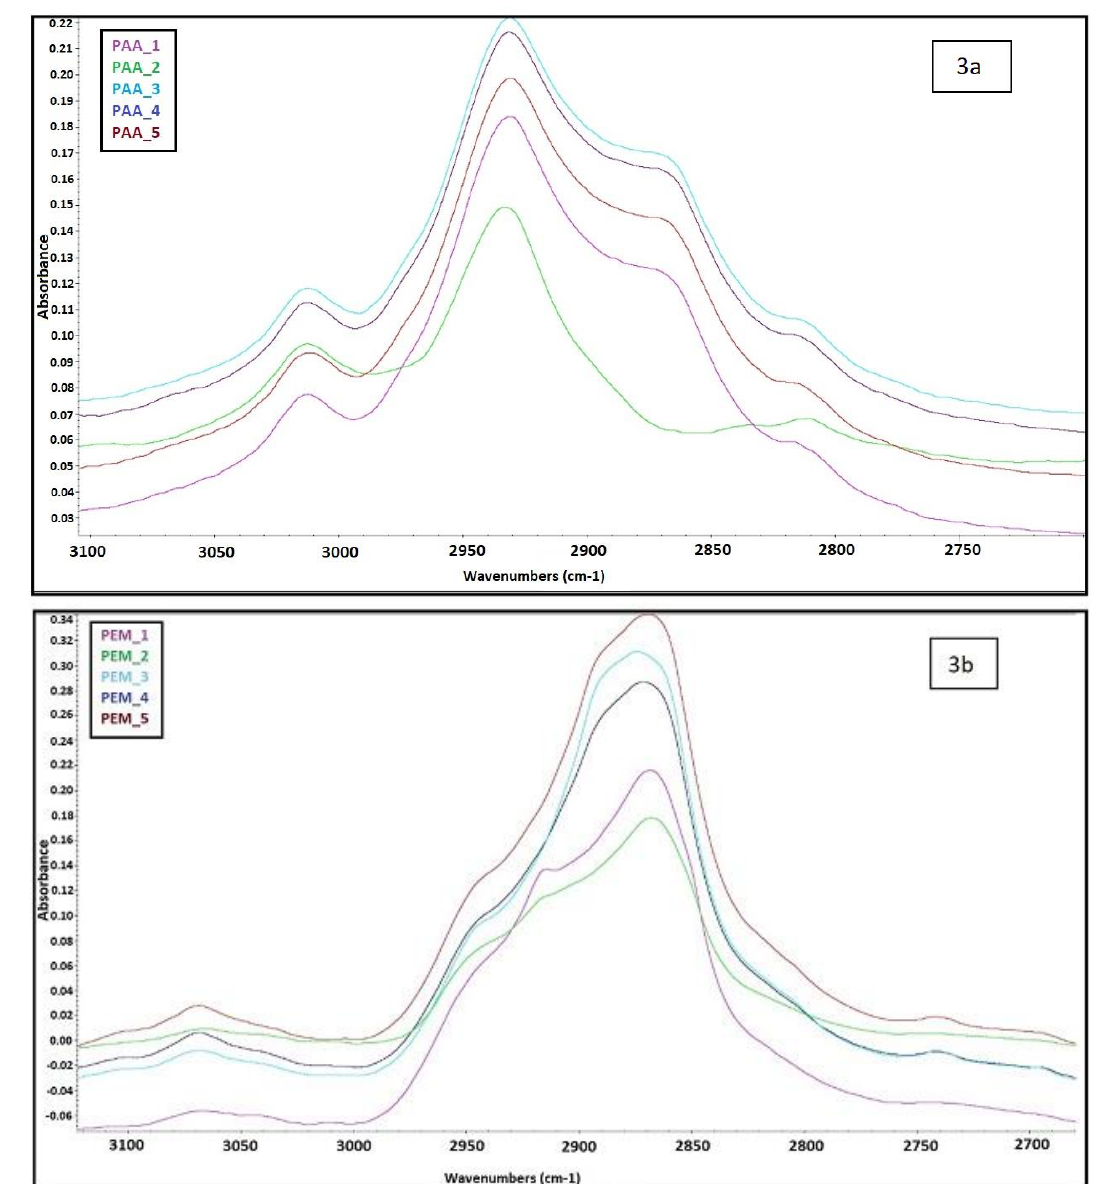
Figure 3. Zoomed Fourier transform infrared (FTIR) spectra of poly (amic acid)_1-poly (amic acid)_5 (PAA_1–PAA_5) solutions ( a ) and PEM_1–PEM_5 membranes ( b ) between 3100 and 2700 cm −1.